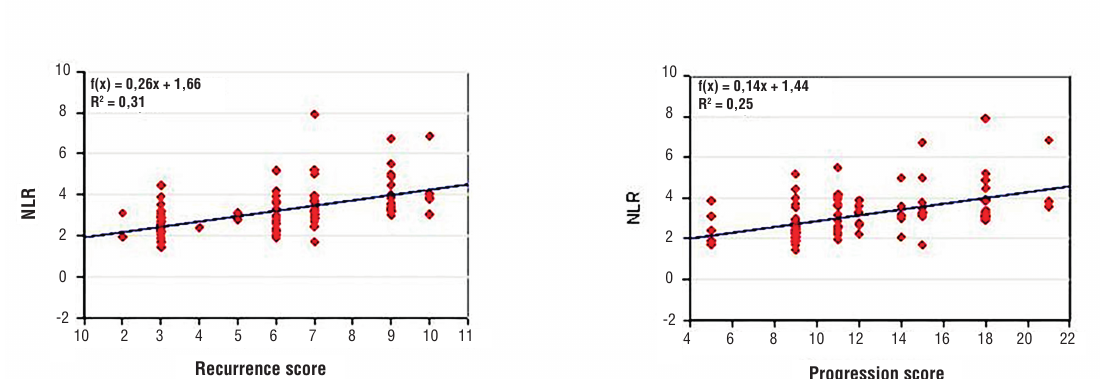
Figure 1 - Correlation between NLR and recurrence risk score and progression risk